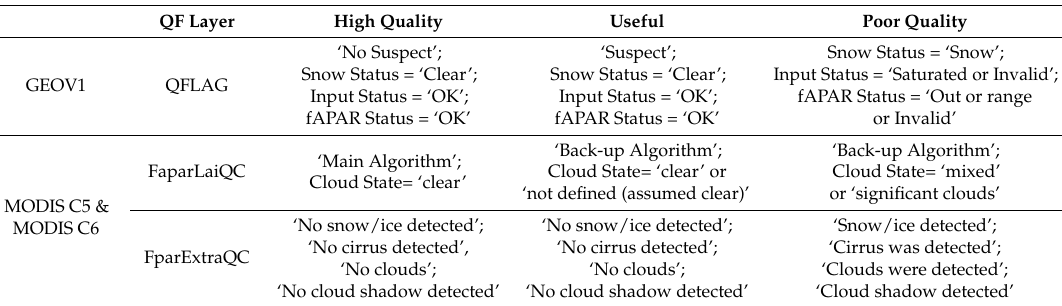
Table 2. Quality flag for the three products under